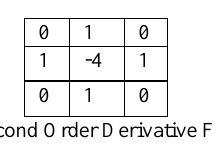
Figure 1. Second Order Derivative Filter